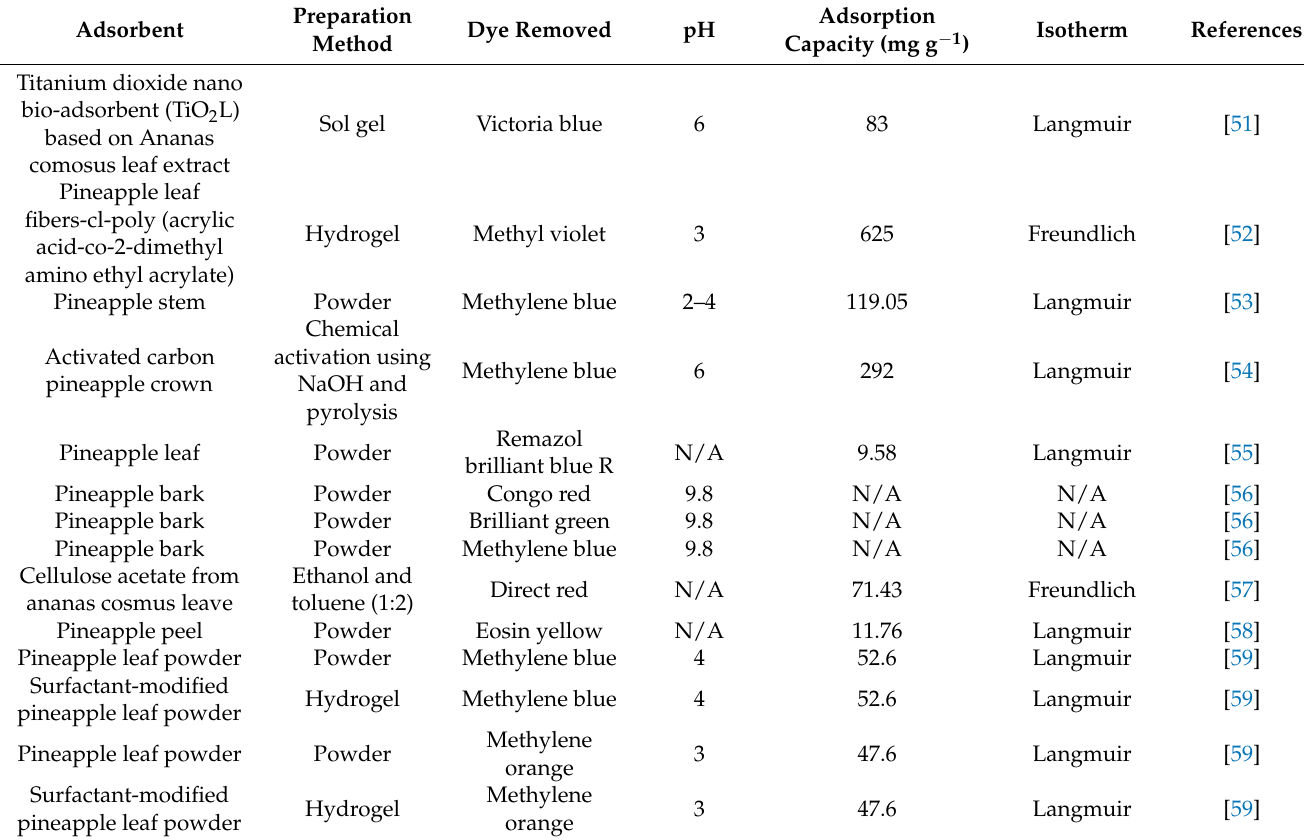
Table 1. Summary of various adsorbents prepared for the removal of dyes in aqueous